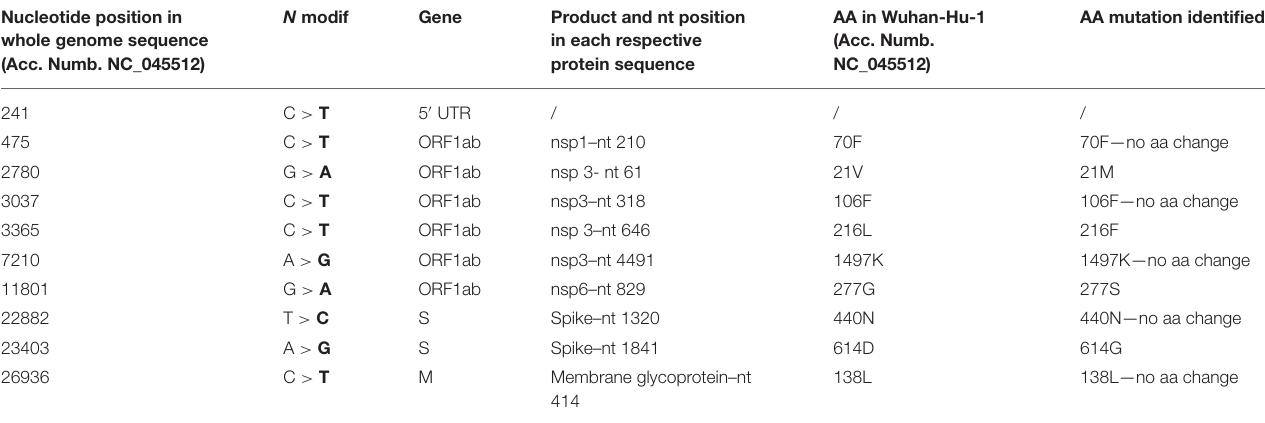
N modif Gene Product and nt position